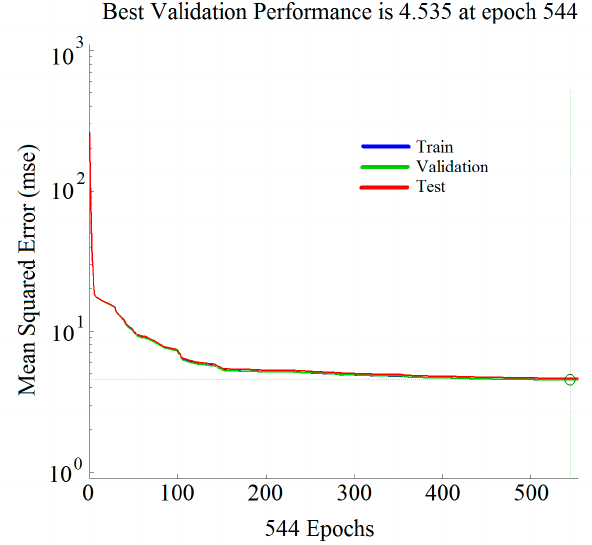
Algorithm: Levenberg ‐ Marquardt backpropagation 2.